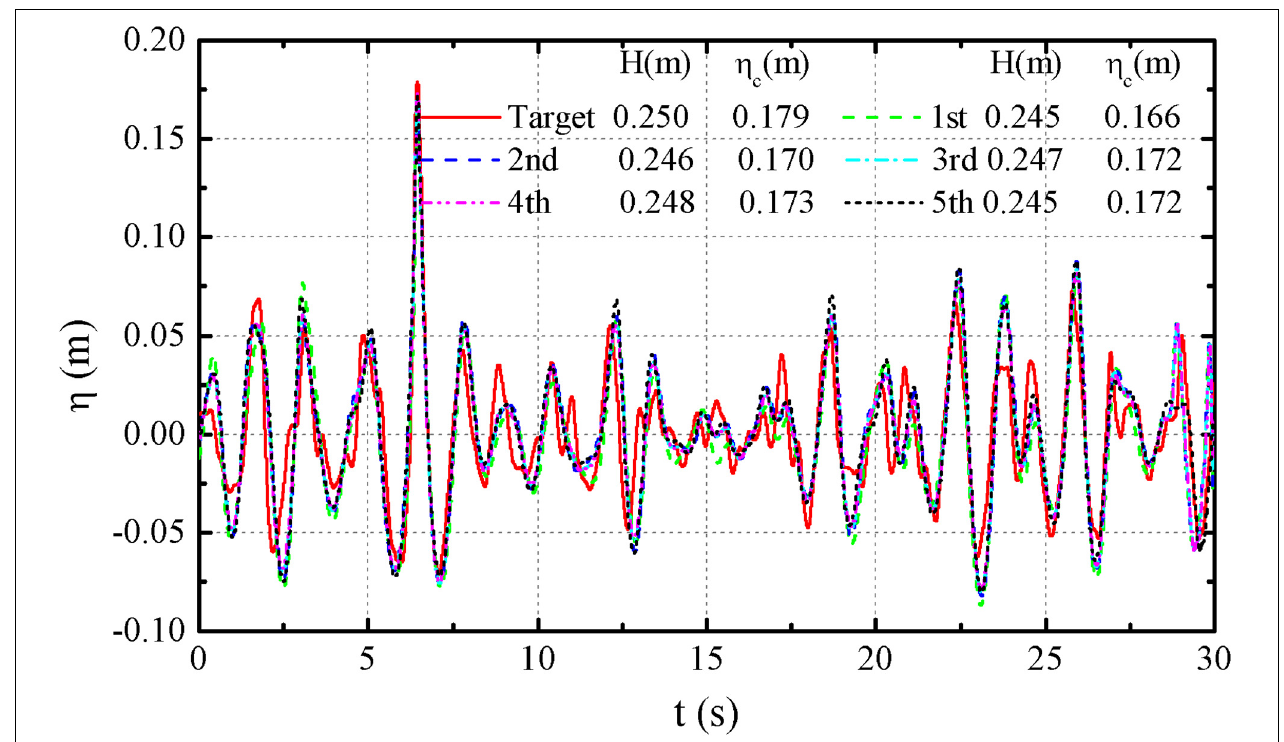
FIGURE 4 | Comparison of the iterative modification results with the targets.